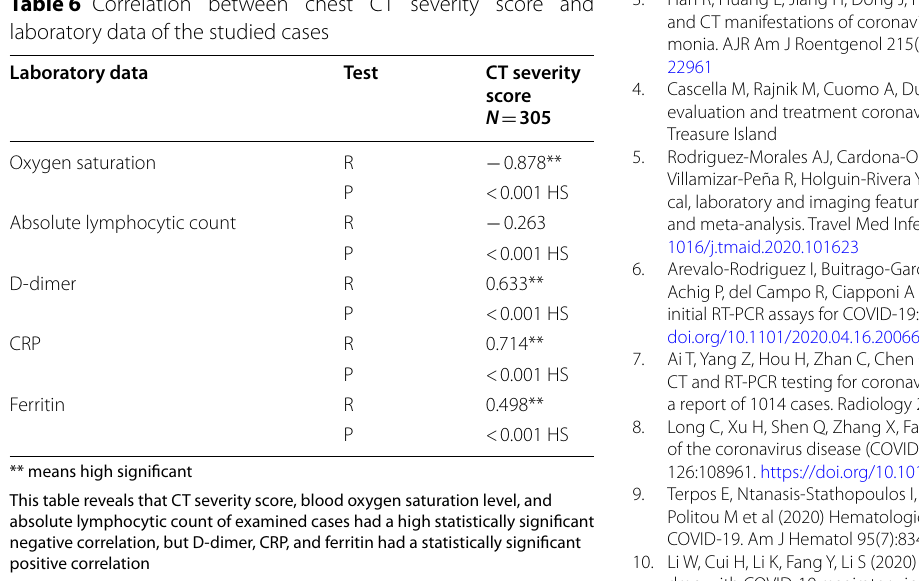
Table 6 Correlation between chest CT severity score